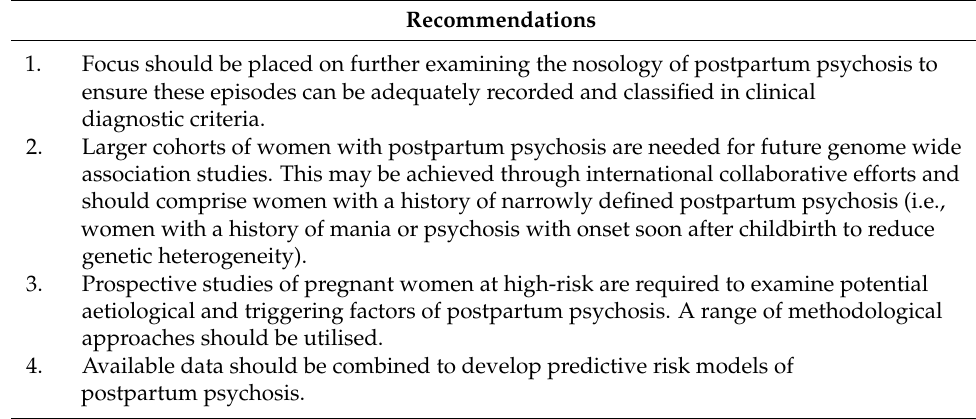
Table 3. Key recommendations of review for further